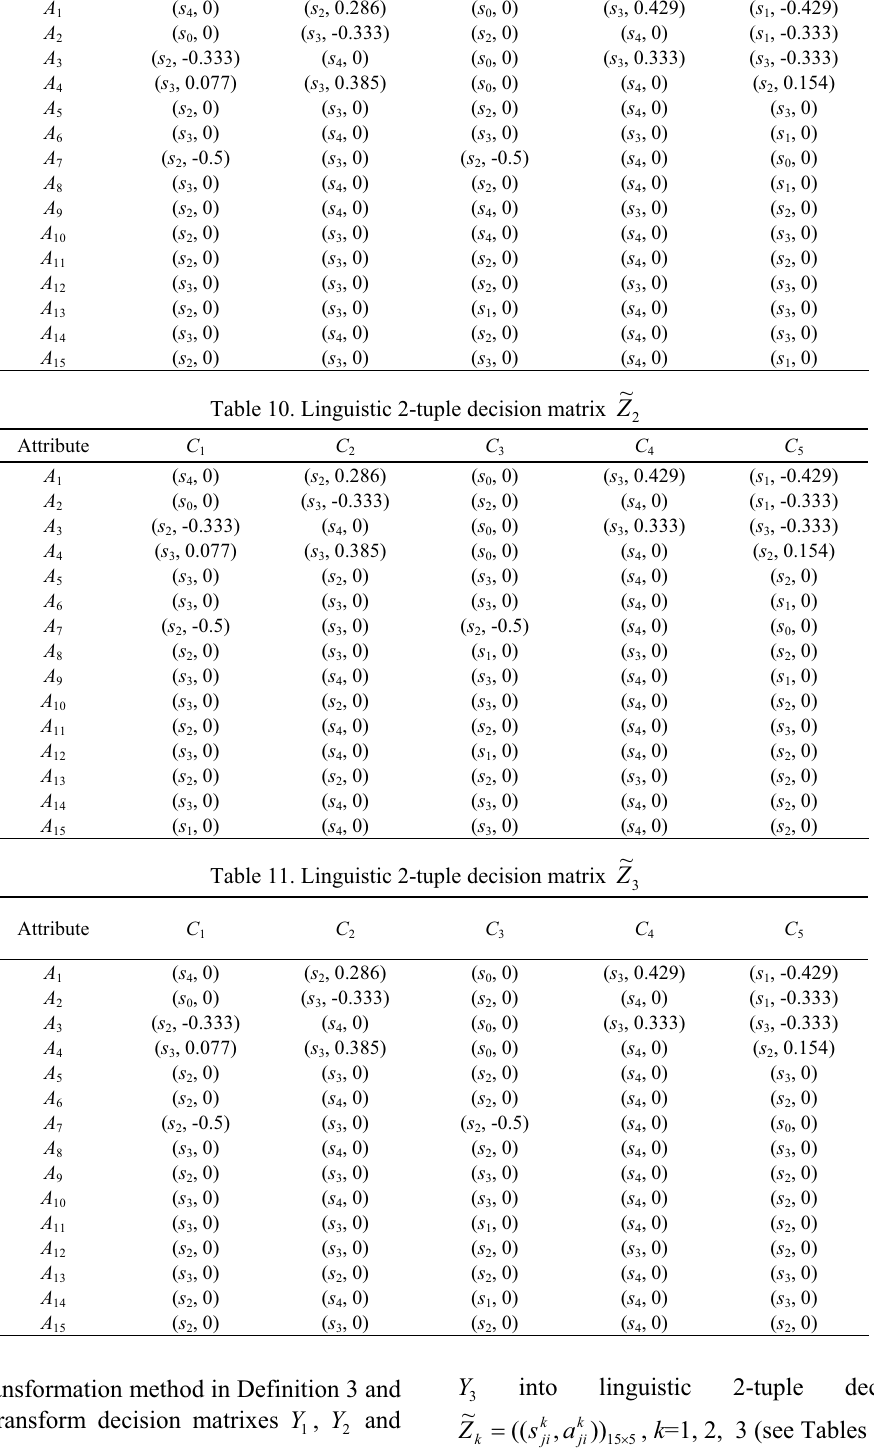
Table 9. Linguistic 2-tuple decision matrix